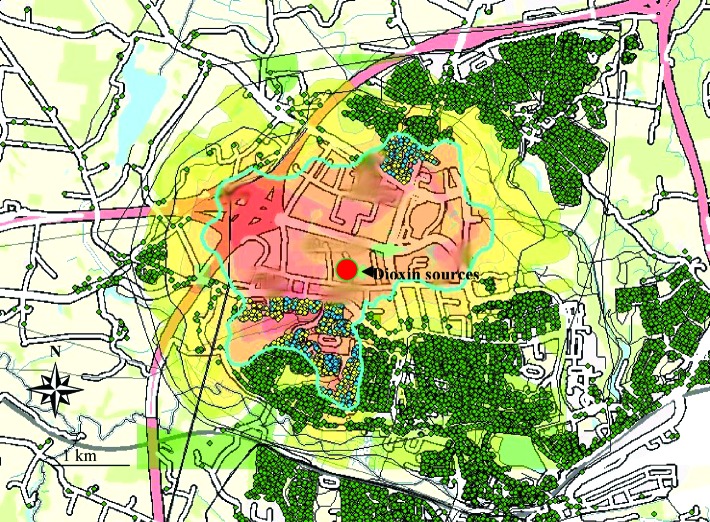
Demarcation of zone 3 and the addresses (and individuals) in blue within the polygon. Cancers diagnosed among the individuals in zone 3 during 1986–1998 are marked in yellow (overlayed on the blue dots).